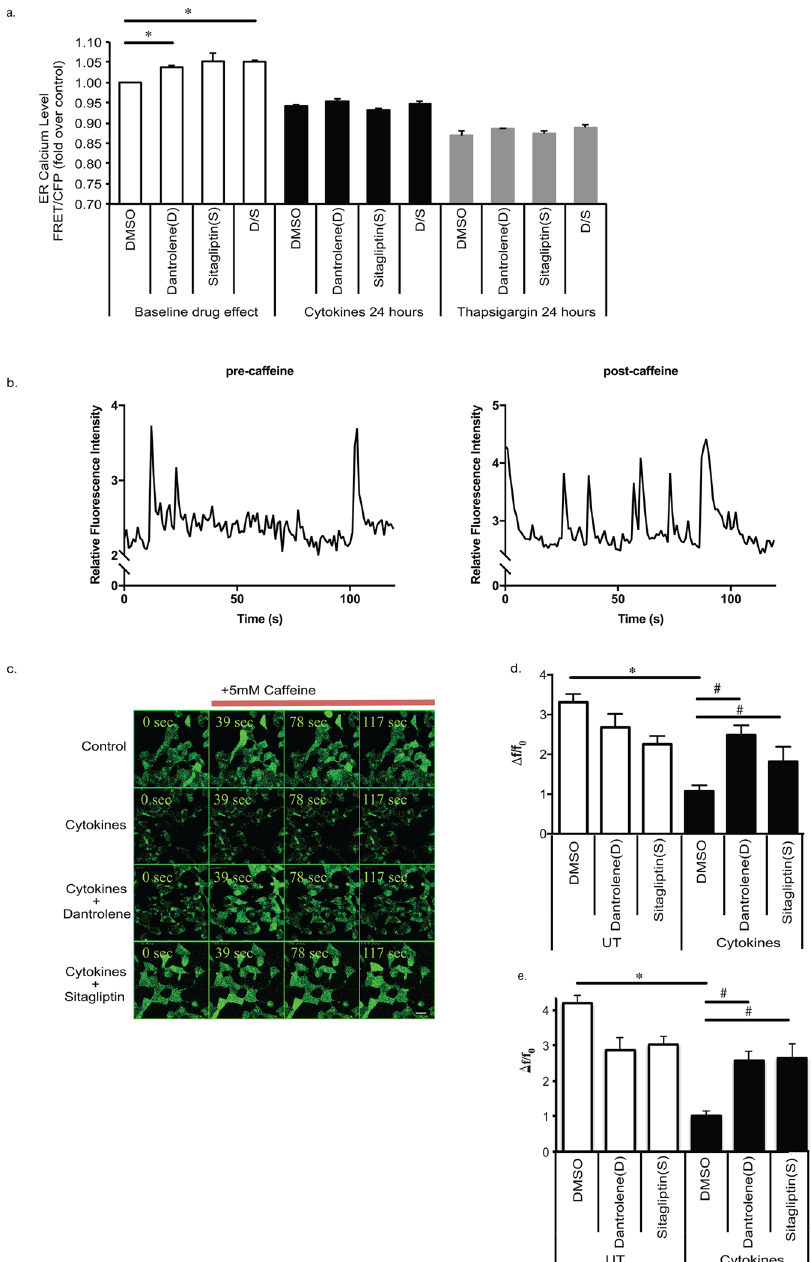
Figure 2. Dantrolene and Sitagliptin Restore Caffeine Mediated ER Calcium Release in Cytokine and ER Stressed Β eta Cells. ( a ) INS-1E cells were treated with 100 nM dantrolene, 200 nM sitagliptin or a combination of the two drugs for 24 hours followed by treatment with 10 nM thapsigargin for 24 hours or 6–24 hours of cytokine cocktail (IL-1 β and IFN- γ 50 ng/mL) treatment. ER calcium levels were monitored in INS-1E cells stably expressing the D1ER probe via FACS analysis and presented as FRET/CFP. Fluorescence was monitored continuously for two minutes in INS-1E cells loaded with Fluo-4 AM imaged at baseline and after 5 mM caffeine stimulation and single cell calcium oscillation tracings were produced as depicted in panel b. Panel c shows representative single plane images at different times during the 2 minute acquisition after the addition of caffeine. Graphical representation of the relative change in fluorescence intensity averaged over 2 minutes of image acquisition, expressed as Δ F/F 0 ( Δ F is the change in fluorescence intensity of the caffeine stimulated cells relative to the basal condition F 0 ) is displayed in the presence (panel d) and absence of calcium in the media (panel e). The average represents values over 2 minutes in 50 cells normalized for variations in the concentration of the dye in different cells. Data are expressed as mean ± SEM from at least three independent experiments. * p < 0.05 compared to control; # p < 0.05 compared to cytokine or TG treated cells via one way ANOVA